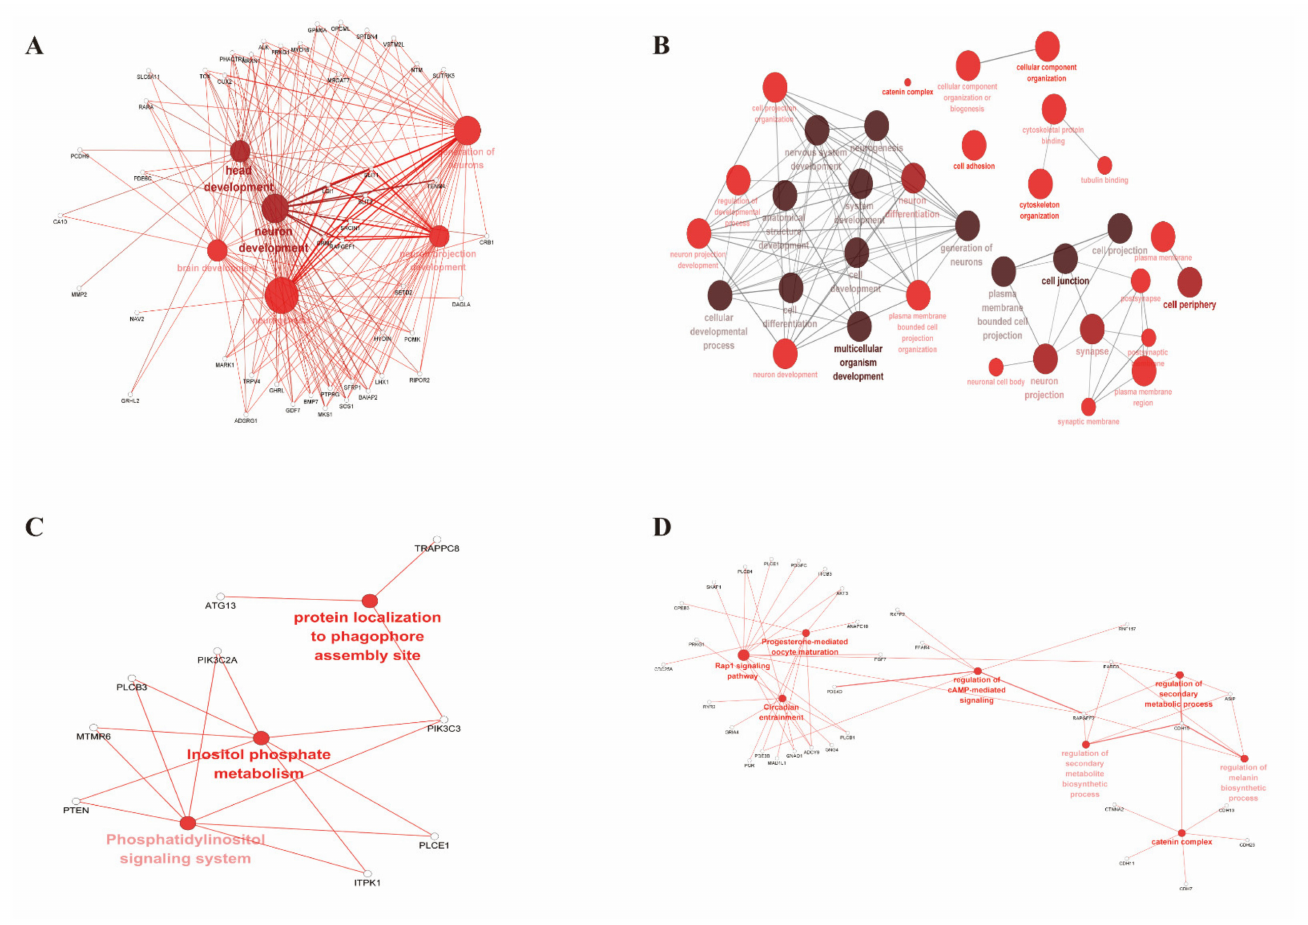
Figure 8. Functional enrichment analysis of the genes that were correspondingly annotated based on the selected regions significantly enriched between popC (Hainan Black goat) and popD (Dazu Black goat), popE (Jining Grey goat), popF (Boer goat), and popG (Alashan Cashmere goat), respectively ( p < 0.05). Solid dots and hollow dots represent the function and gene, respectively; the color and size of solid dots represents the degree of genes in the correlation network, that is, the larger and the deeper color of the solid dots represent the more genes associated with the